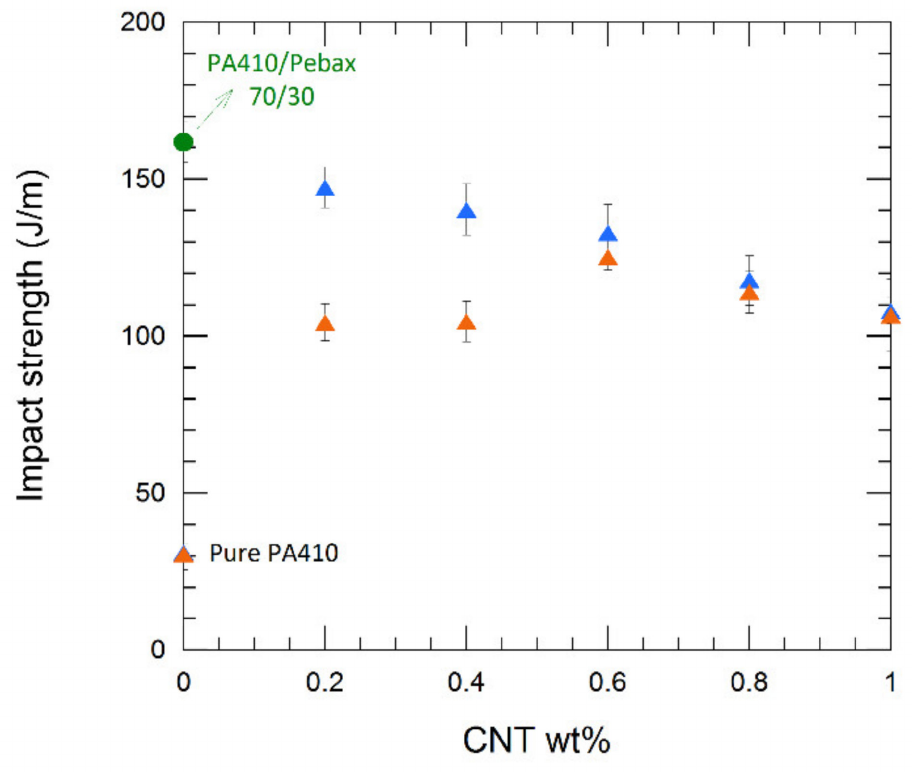
Figure 12. Impact strength of PA410/Pebax/CNT ( (cid:78) ) and PA410/PA6/Pebax/CNT ( (cid:78) ) NCs vs. the CNT content. Pure PA410 and the PA410/Pebax2 70/30 blend have been represented as a reference.